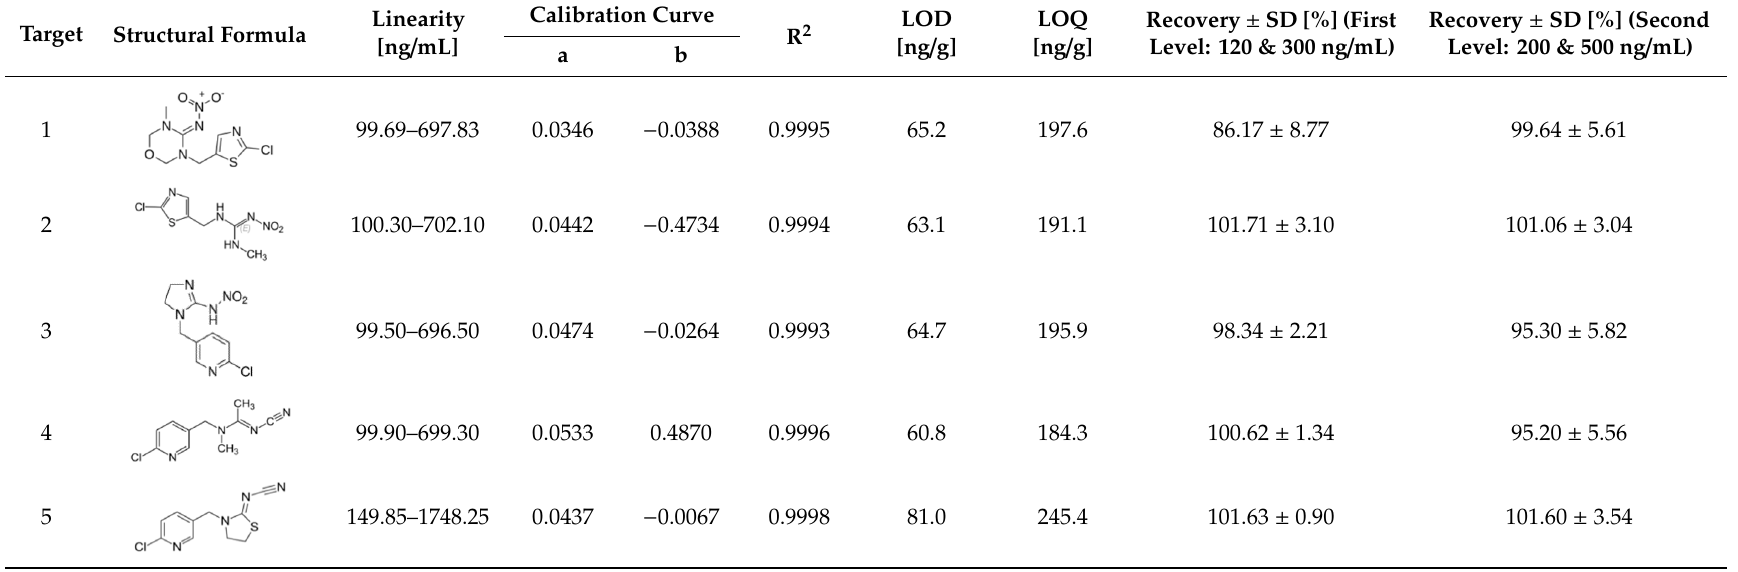
Table 2. Results of method validation, where: 1 = thiamethoxam, 2 = clothianidin, 3 = imidacloprid, 4 = acetamiprid, 5 = thiacloprid.